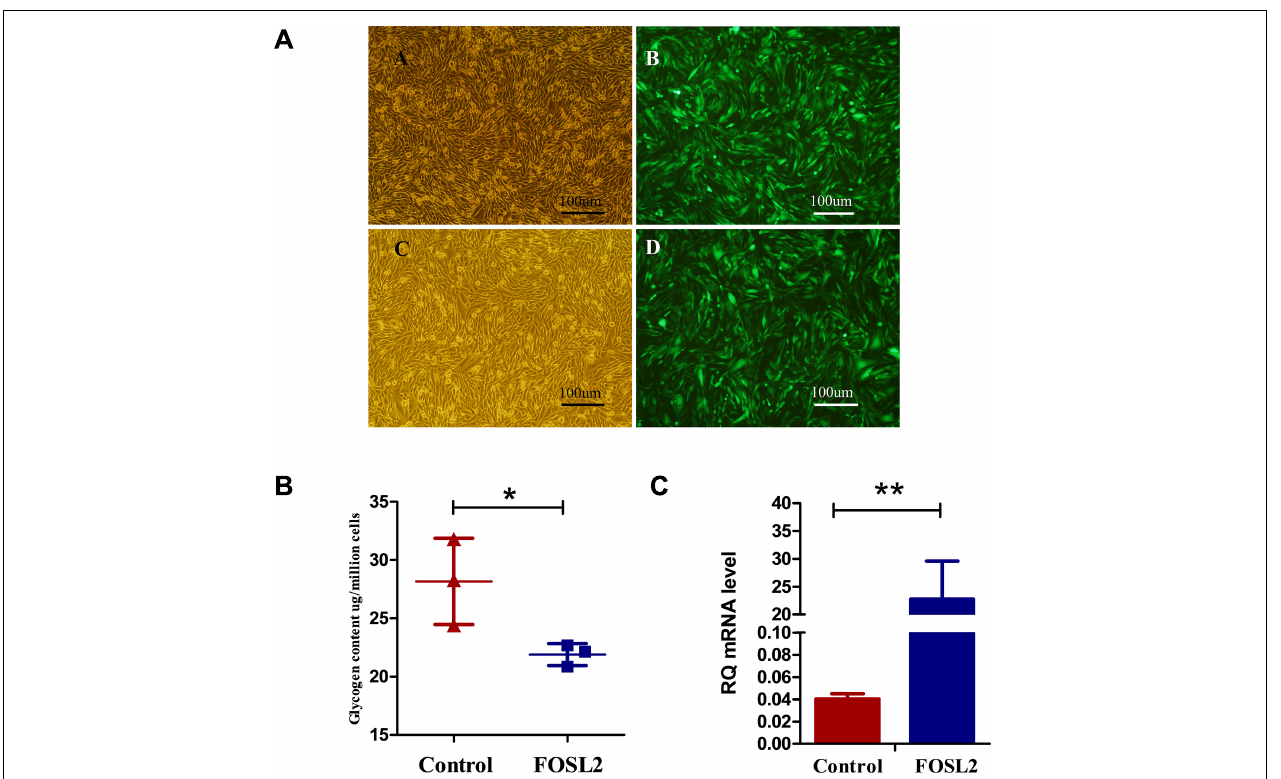
FIGURE 3 | (A,B) Bright-field images and fluorescence microscopy images of transfected cells of chickens from the control group, respectively. Bright-field images and fluorescence microscopy images of cells from the FOSL2-transfected group, respectively. More than 80% of DF1 cells expressed green fluorescent protein. Scale bar = 100 µ m. (B) The glycogen of control and FOSL2 overexpressing DF1 cells ( P = 0.046). Control refers to the control group, and FOSL2 refers to the overexpression group of FOSL2. (C) Expression level of FOSL2 gene by qRT-PCR in the control group and FOSL2 overexpression group ( P < 0.001). Data are presented as the mean ± SEM. Control refers to the control group, and FOSL2 refers to the overexpression group of FOSL2.RQ: relative